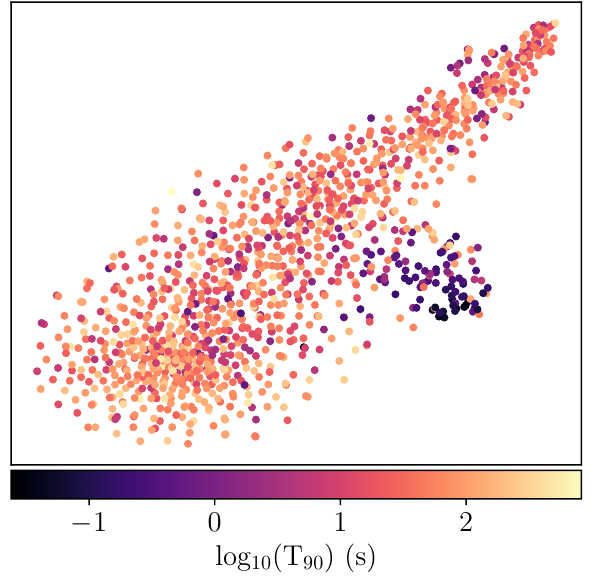
Figure 10. 2D t-SNE representation of the wavelet coefficients and PCA features extracted from the light curves measured in Band 3 for Swift /BAT (50–100keV). The plot is coloured by burst duration T 90 .